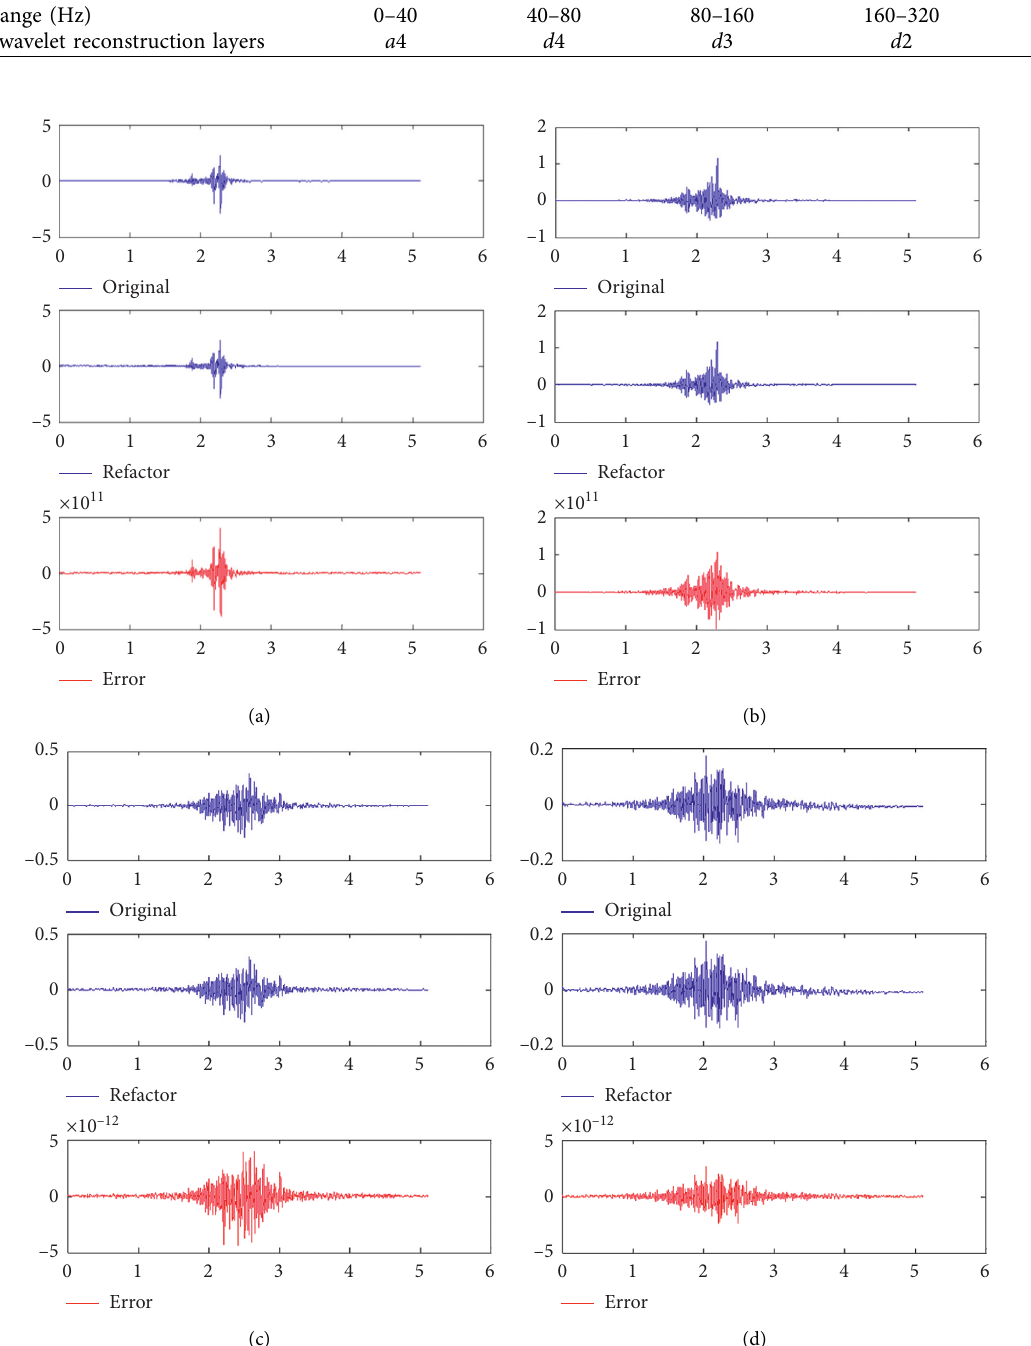
Figure 9: Comparison and error between the original signal and reconstructed signal: (a) 50cm, (b) 100cm, (c) 220cm, and (d)